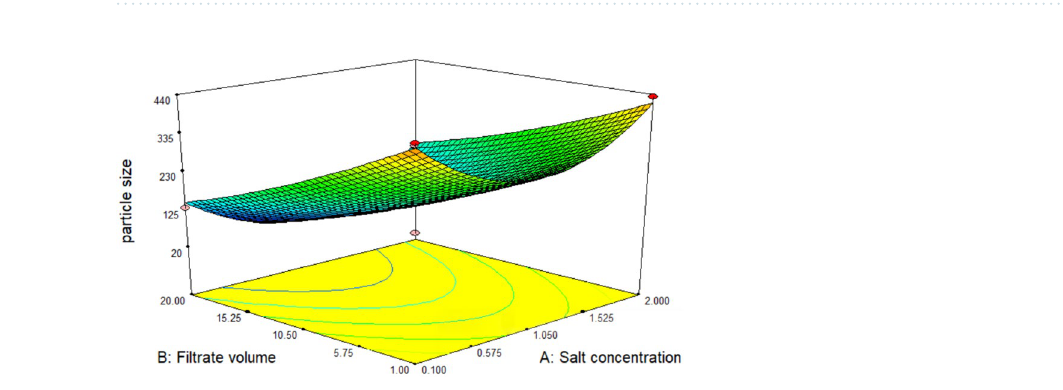
Figure 12. 3-D. Response surface plot showing the interaction between the filtrate volume and salt conc. and its effect on the produced particle size.